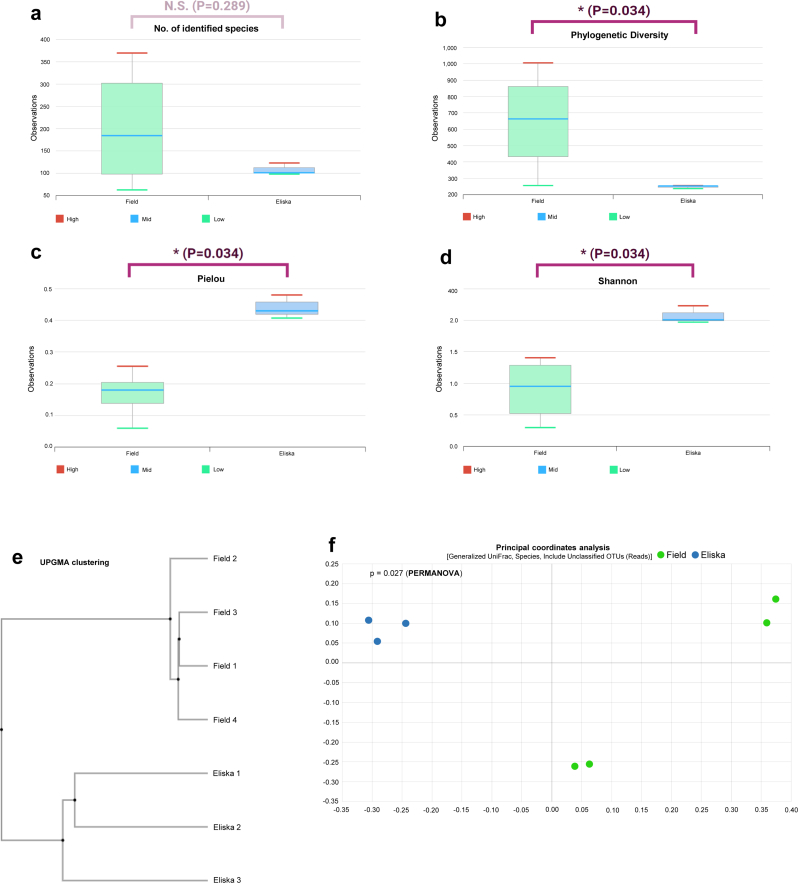
Box plots showing the alpha diversities (measurement of species richness and evenness within a habitat unit) of: (a) the number of operational taxonomic units (OTUs) found in microbiome taxonomic profiling (MTP); and (b) phylogenetic diversity (abundance); (c) Pielou diversity (equity); and (d) Shannon diversity (measurement of richness and equity in the distribution of species) among the samples from Eliska. Bars indicate the median, and the hinges represent the lower and upper quartiles. In panel (a), there are no statistically significant differences between the two groups. However, in panels (b), (c), and (d), there are statistically significant differences between the two groups. (e) Unweighted pair group method with arithmetic mean (UPGMA) clustering, and (f) principal-coordinate analysis depicting differences in taxonomic compositions of bacterial communities in Amblyomma gemma samples collected from Eliska's body and from the field. * indicates statistical differences between the two groups of ticks (Wilcoxon rank-sum test, p < 0.05).